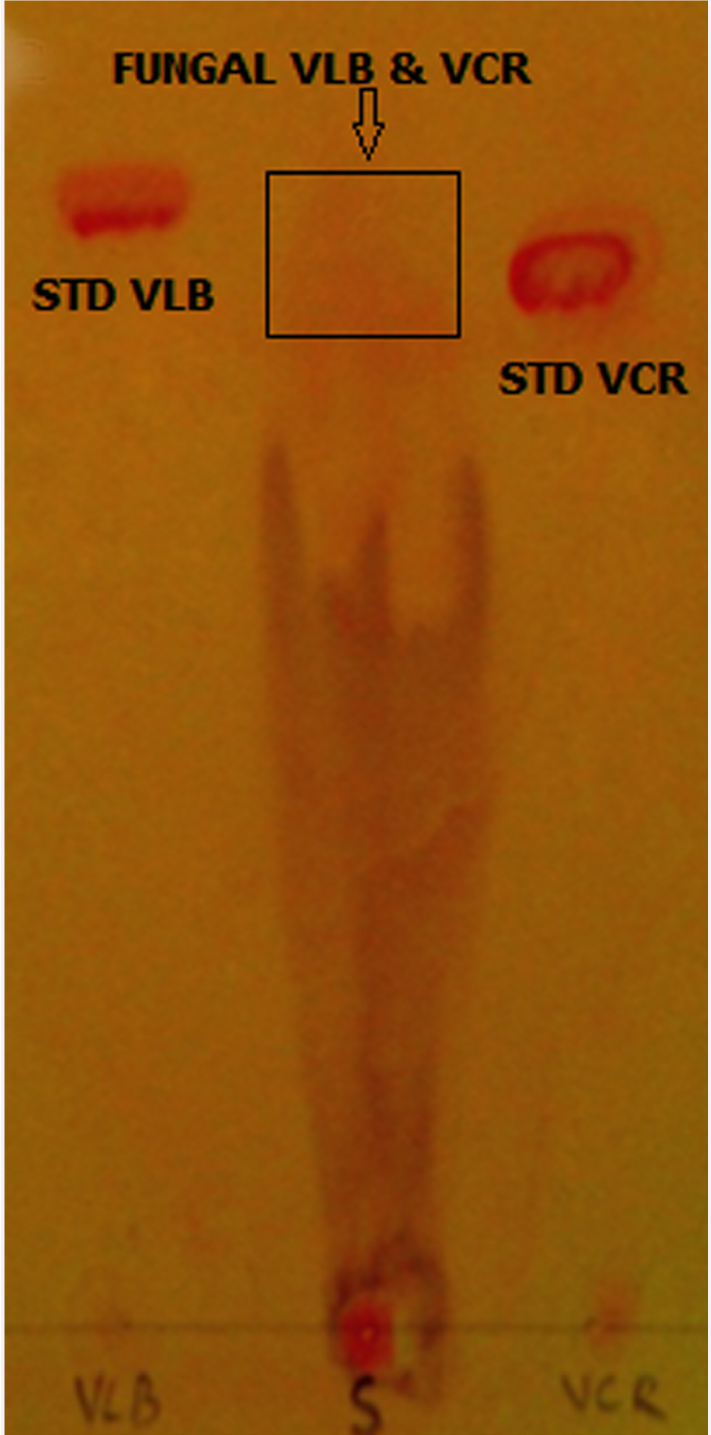
Fig 8. Thin-layer chromatography analysis of T . radicus — CrP20 crude extract on a silica gel aluminum sheet.